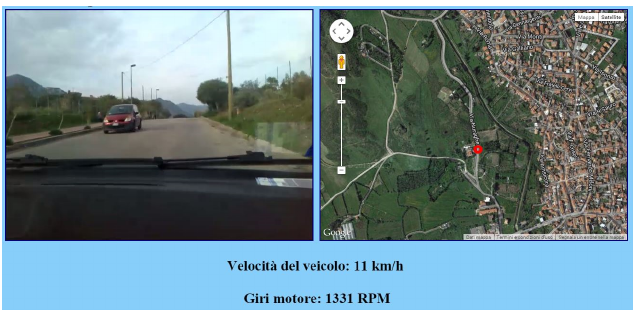
Figure 7. Screenshot of the web MIoT application with digital speed and rpm